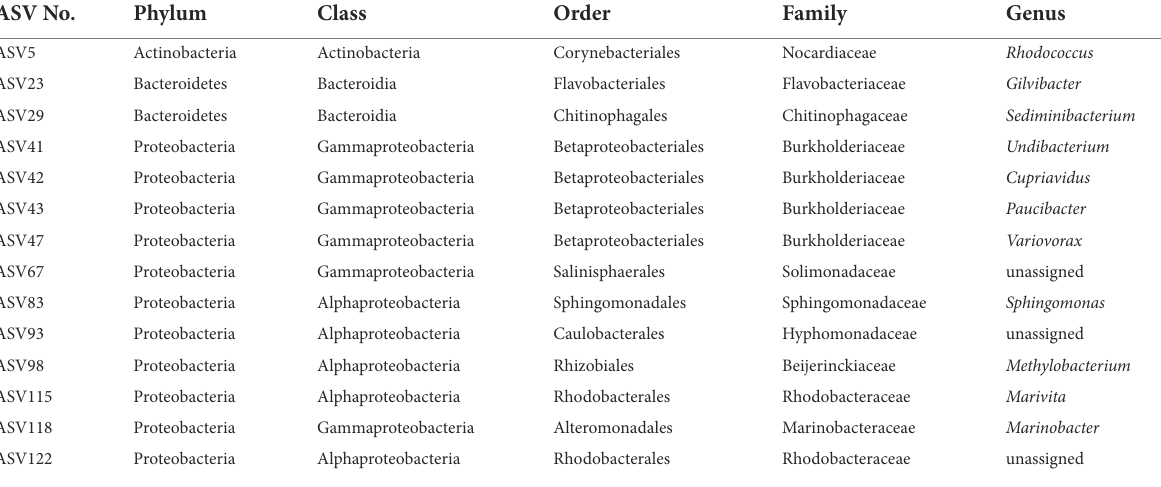
TABLE 3 Core community of 14 ASVs shared between all four strains of Prorocentrum cordatum. ASV